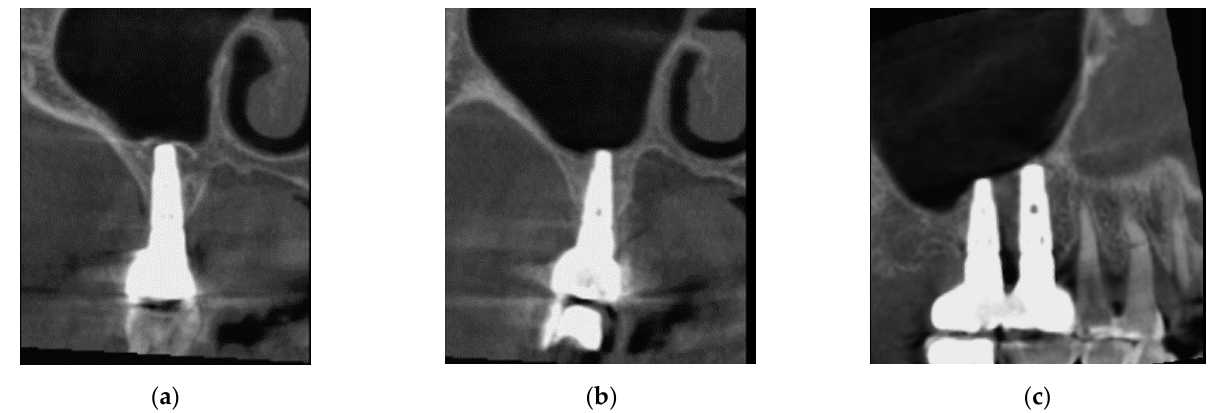
Figure 4. Patient #1. CBCT performed 2 months after surgery showing: ( a ) and ( b ) cross-section images of the surgical sites with graft still surrounding both implant apexes; ( c ) Panorex view showing almost complete sinus opacification without evidence of residual grafting material disseminated into the cavity.